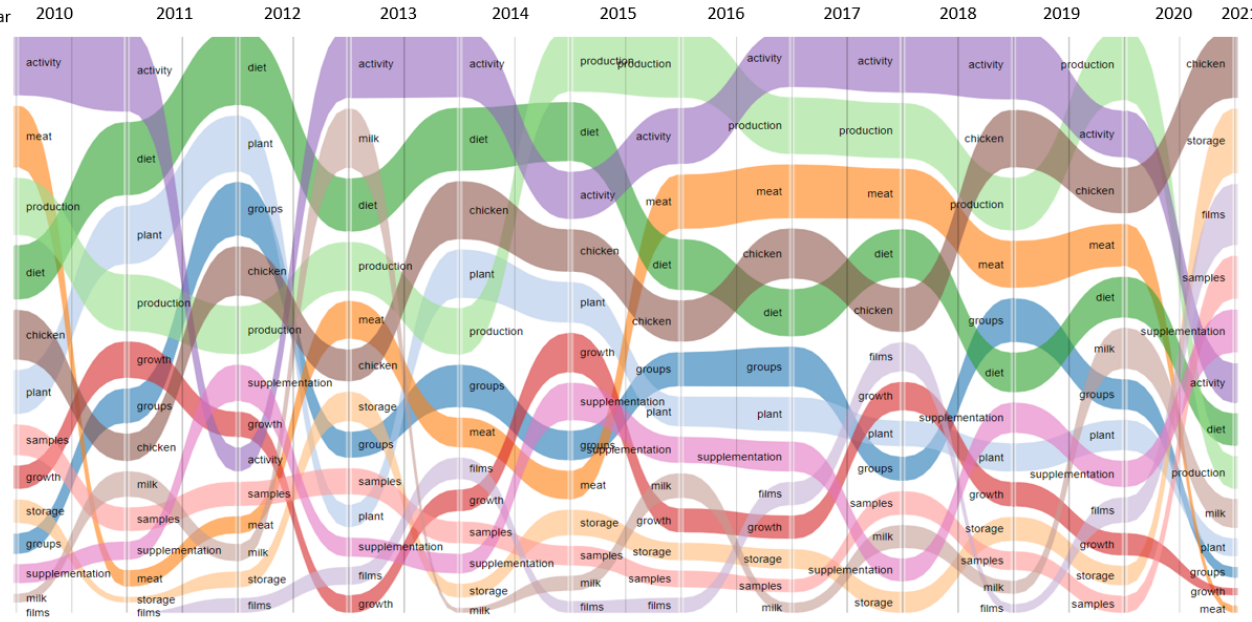
Figure 2 “Epic epoch” graph allowing to visualize the first 5 most used keywords in each article for each year, from 2010 to 2021.